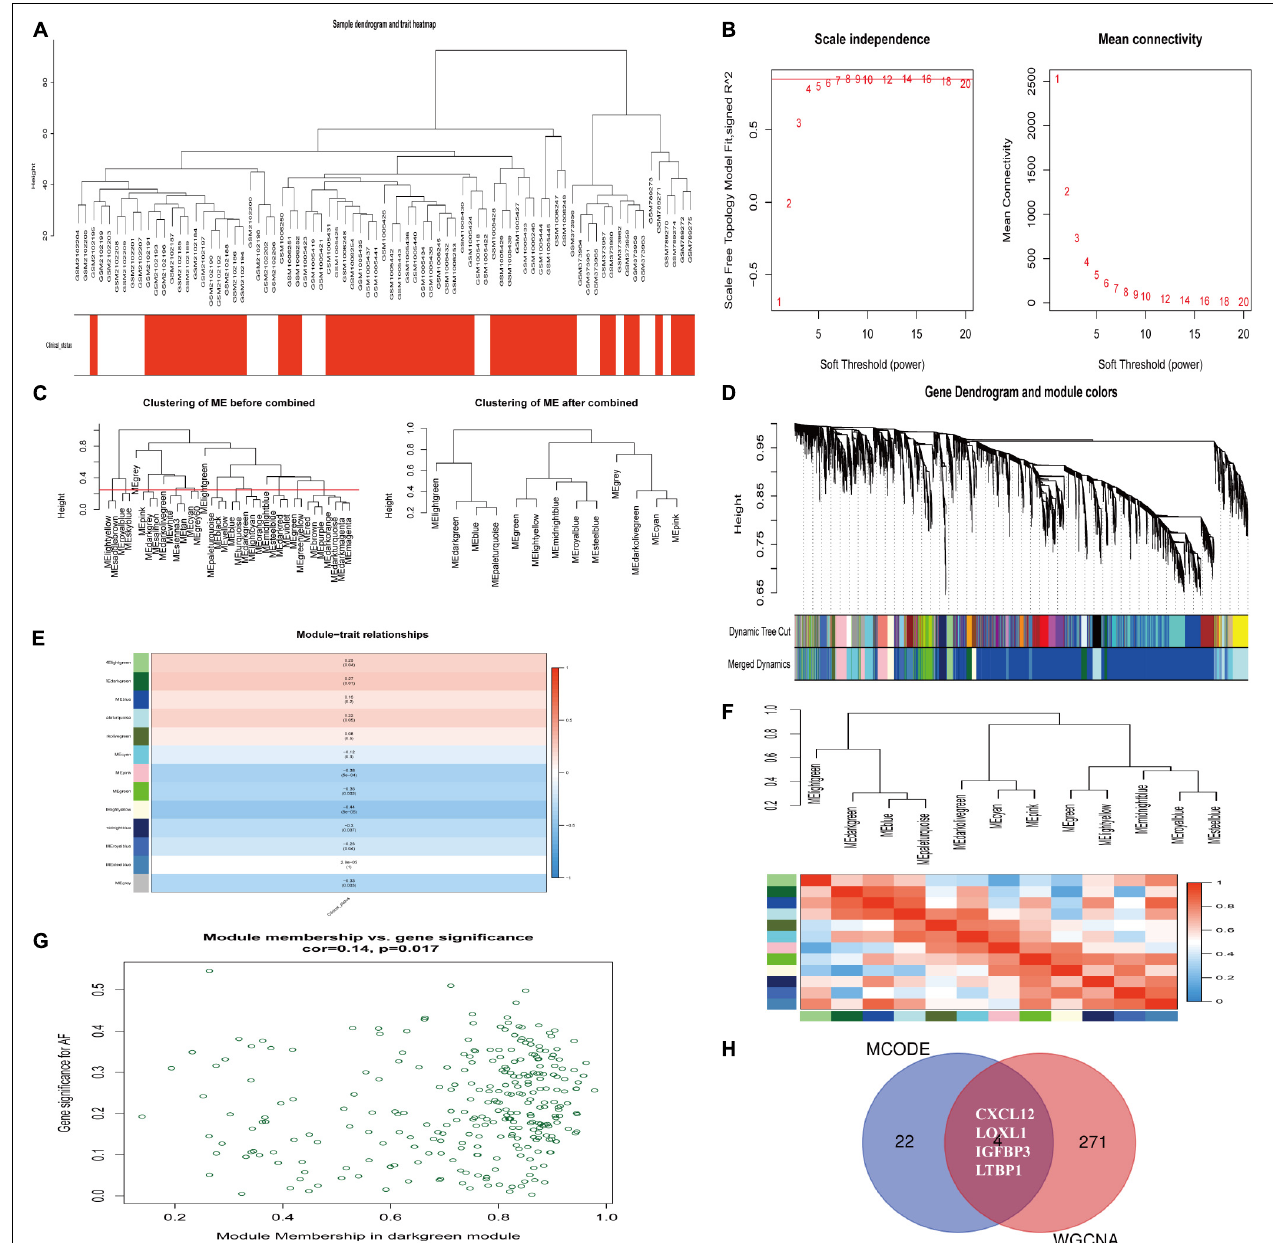
FIGURE 5 | Identification of hub modules associated with AF by WGCNA. (A) Clustering dendrograms of genes from normalized six datasets. In the column of clinical status, red indicates AF, and white means the SR individuals. (B) The scale-free fit index (left) and the mean connectivity (right) for various soft-thresholding powers. (C) Clustering of module eigengenes. The cut height (red line) was 0.25. (D) Hierarchical cluster tree. (E) Heatmap showing the relationship between module eigengenes and clinical status. The numbers in cells mean the correlation coefficients and p -values. (F) Cluster analysis and heatmap of the genes in different modules. Red means a positive correlation, and blue indicates a negative correlation. (G) Scatter plot of module eigengenes in the dark-green module. (H) Venn diagram. The overlapped genes between WGCNA analysis and PPI analysis. AF, atrial fibrillation; SR, sinus rhythm. WGCNA, weighted gene coexpression network analysis; DEG, differentially expressed gene; TOM, topological overlap matrix; PPI, protein–protein